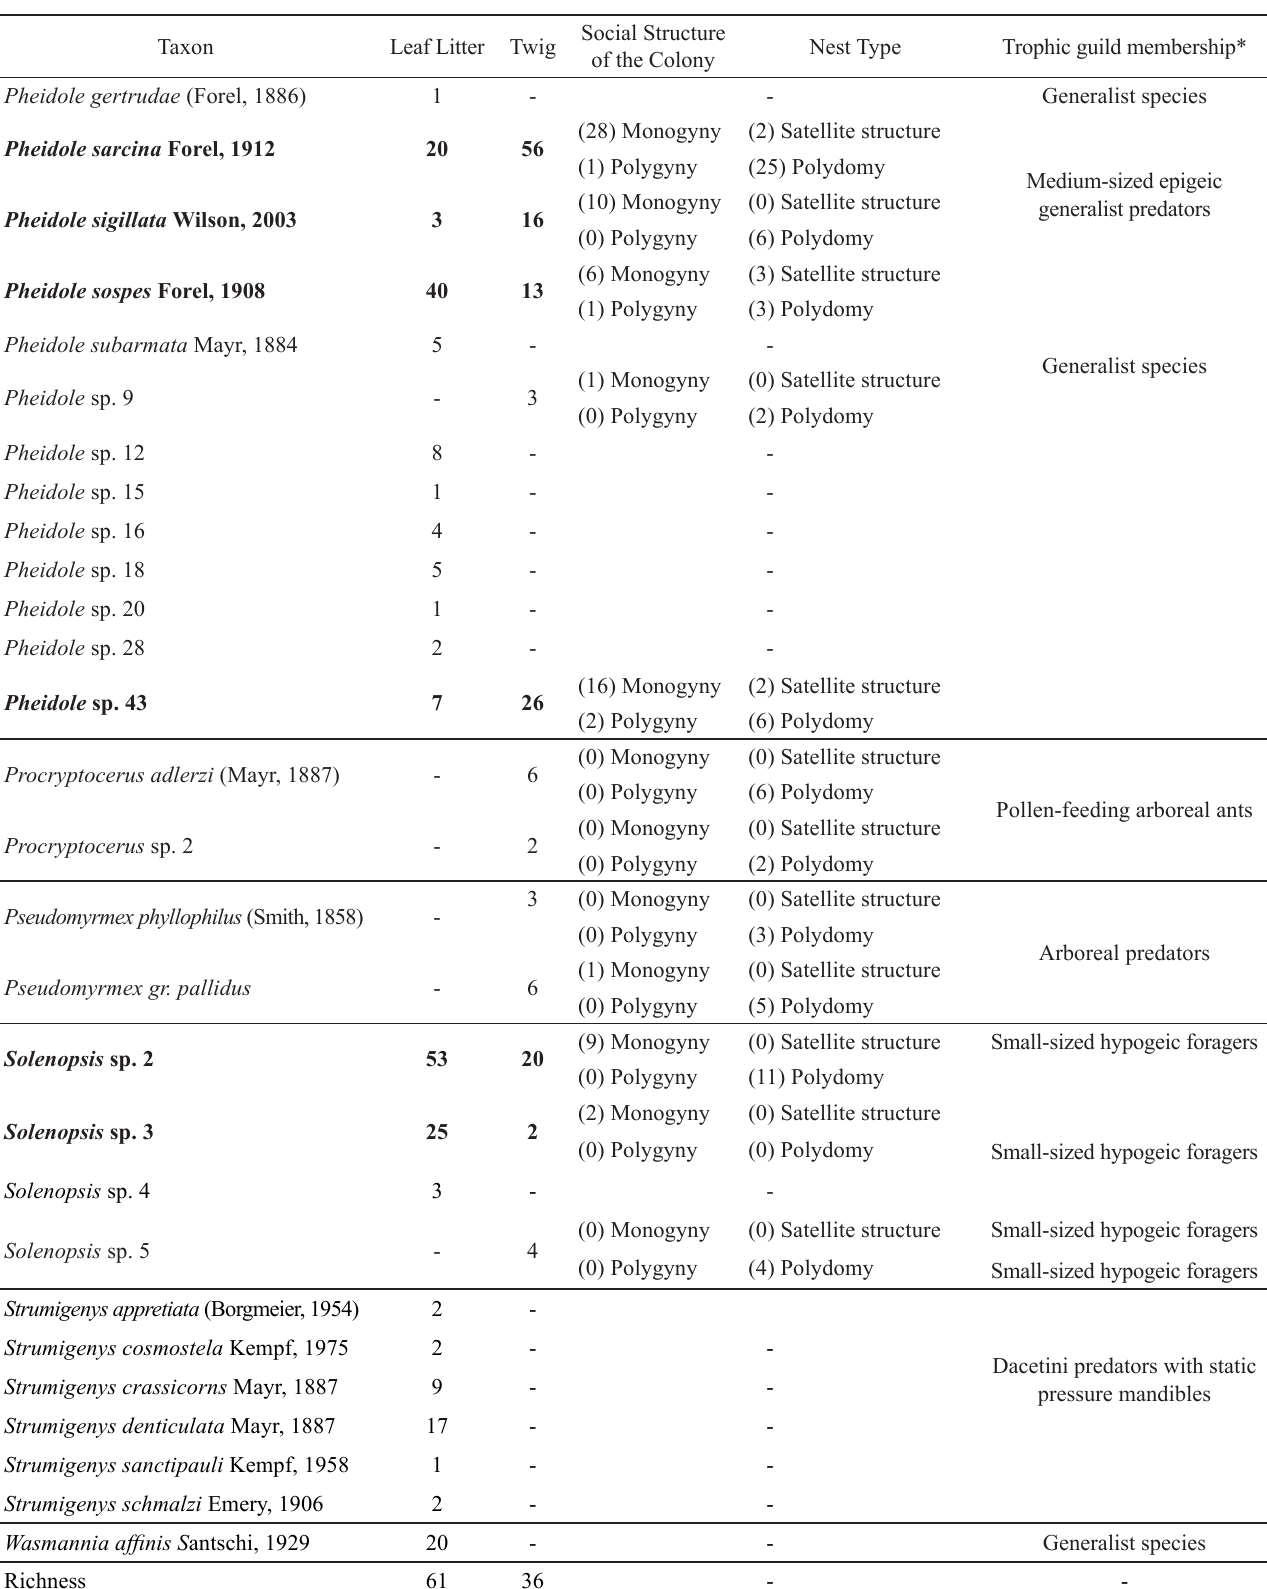
Table 1. List of taxa recorded from leaf litter and twigs, with social structure of the colony, nest type, and guild membership. The total number of nests is shown in parentheses. Species in bold font were recorded both in the leaf litter and in twigs.